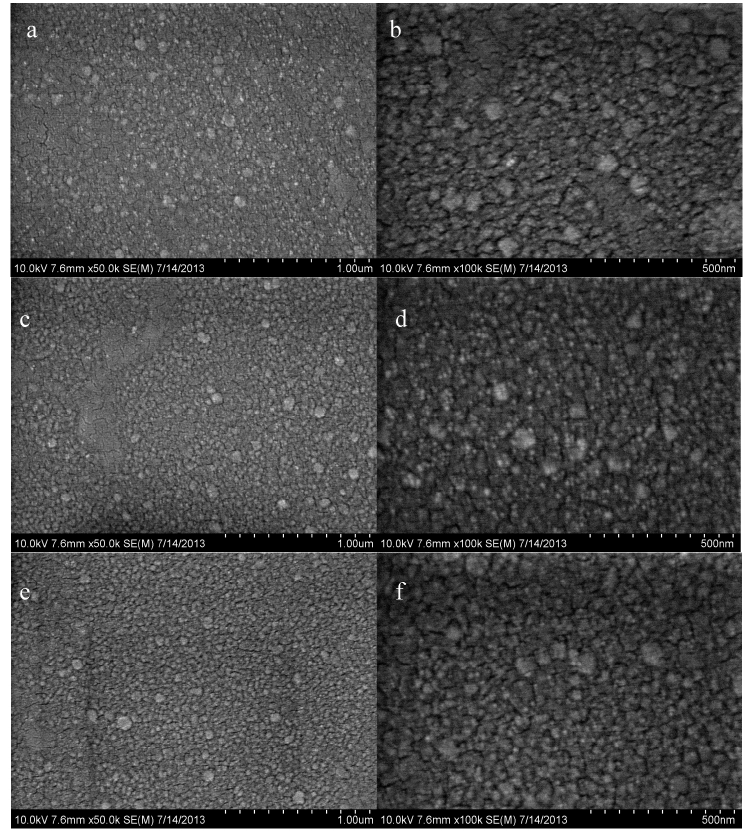
Figure 13. SEM micrographs of Cu 2 S/ZnO (60 nm)/glass complex films deposited with various Cu 2 S deposition thickness: ( a ) (15 nm, 7.6 mm × 50k); ( b ) (15 nm, 7.6 mm × 100k); ( c ) (30 nm, 7.6 mm × 50k); ( d ) (30 nm, 7.6 mm × 100k); ( e ) (60 nm, 7.6 mm × 50k); and ( f ) (60 nm, 7.6 mm × 100k). (50k represents the magnification, 1k = 1000).